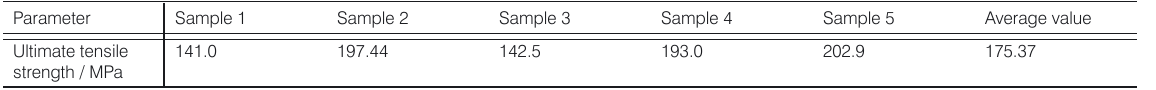
Table 2. Statistical evaluation of tensile strength experiments of textured Ni